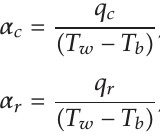
where q r is net radiative heat flux between the cells w at the outside wall or floor and w (cid:4) at other walls; s is the distance of two points; θ 1 and θ 2 are the angles to the surface normal, and λ is heat conductivity. The radiative and convective heat transfer coe ffi cients are defined as α r and α c